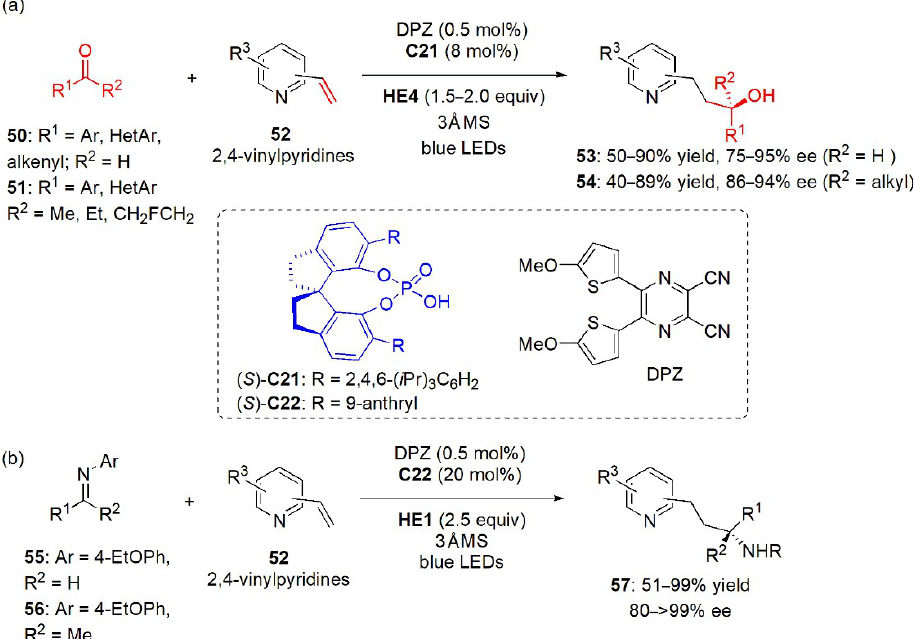
Figure 17. Enantioselective synthesis of 1,4-dicarbonyl compounds via acyl radical conjugate addi- tion to chiral imines derived from enals [86].